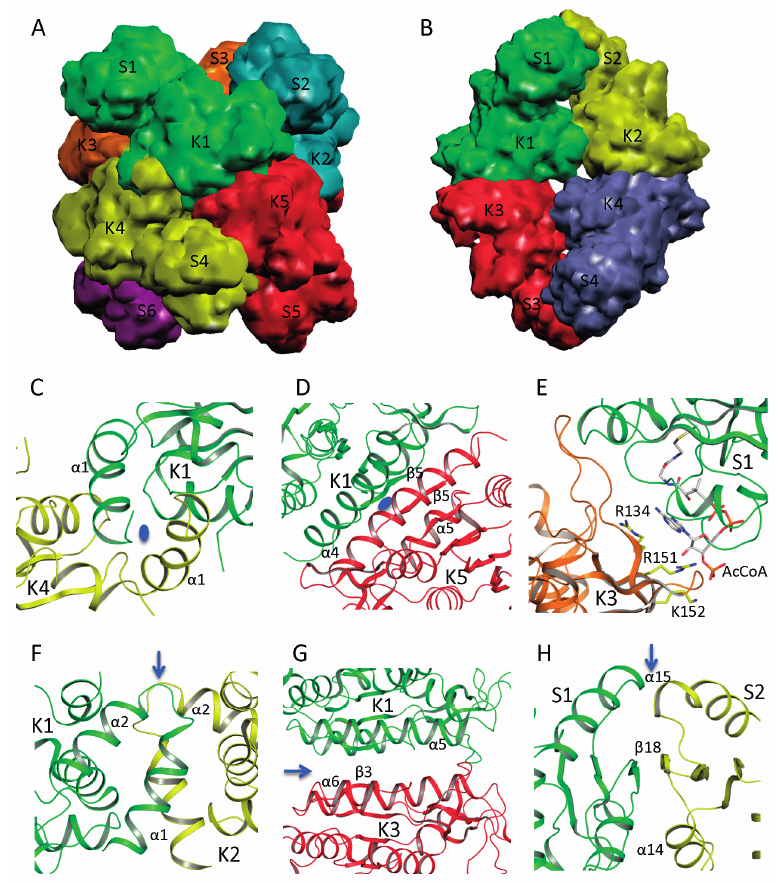
Figure 3. Quaternary structure and interface interactions of ngNAGS and mmNAGS/K.